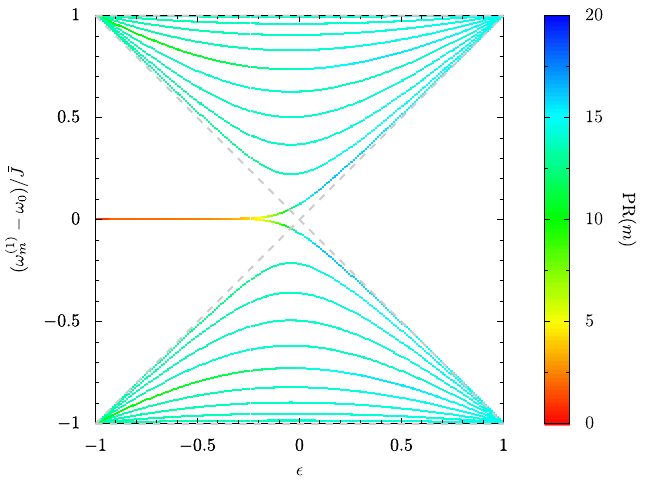
( 1 ) Figure 2. Eigenfrequencies ω m of a finite dimerized chain in the one excitation sector (as measured from ω 0 ), in units of the coupling strength ¯ J , as a function of the dimerization parameter ǫ [cf. Eq. (2)]. Color bar: the participation ratio PR ( m ) of each state m . Edge states are highly localized and thus appear reddish on this scale. Dashed gray lines: region enclosing the extended states, as defined in the infinite chain limit . In the figure, the 10 dimers, leading to a 20-dimensional Hilbert chain is composed of N =